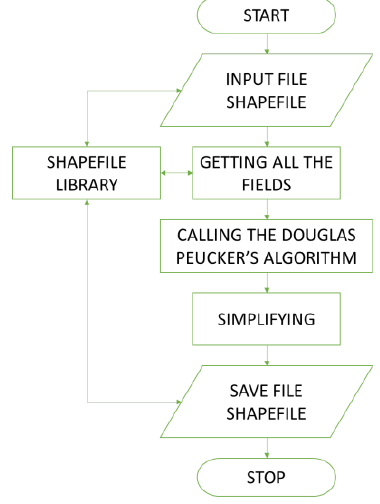
Figure 4: Flowchart of the Douglas Peucker’s line simplification operator